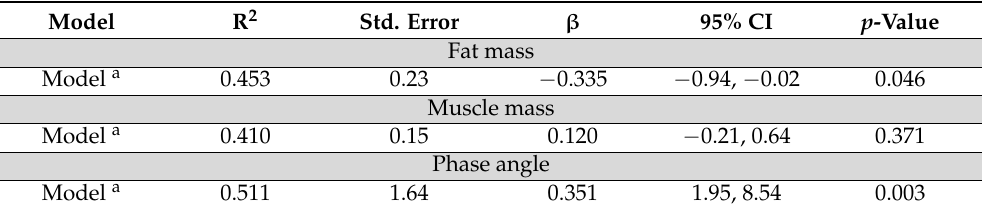
Table 2. Adjusted models using fat and muscle mass, and phase angle as independent variables for determining VO 2max